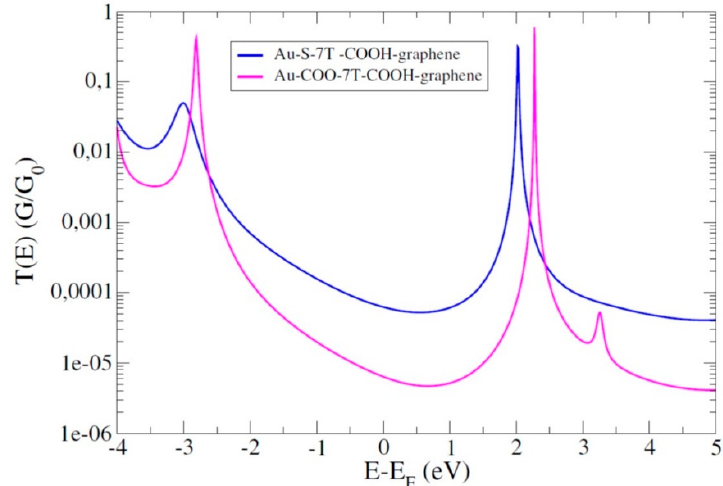
Figure 6. Atomic representation of the different hybrid Au – graphene alkane-based molecular junctions using thiolate and carboxylic acid anchoring groups at each extremity. Reprinted figure from [49] and with permission. Copyright (2019) Wiley-VCH Verlag GmbH & Co.